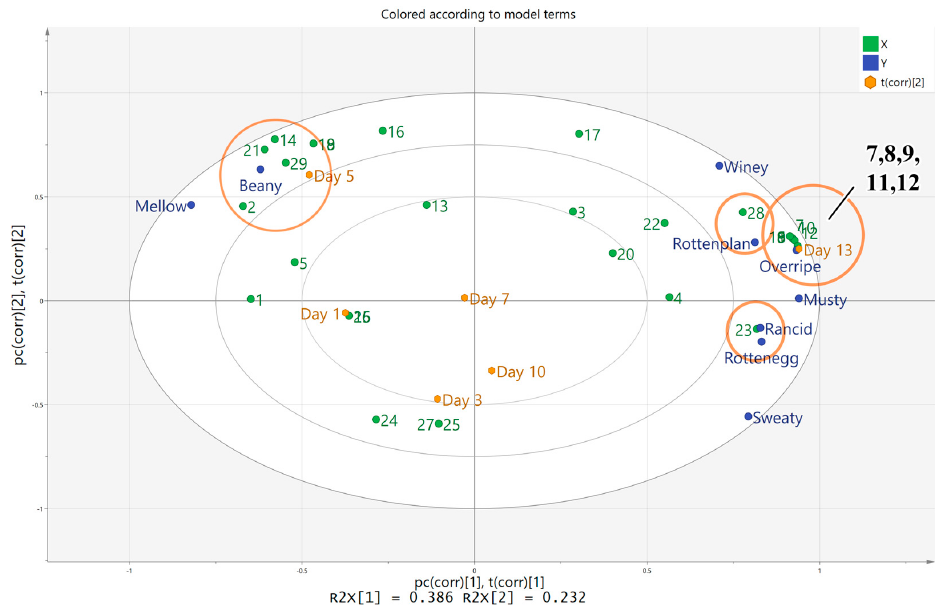
Figure 4. Partial least squares correlation plot from the analysis of the stinky tofu samples. The was derived from 29 volatile compounds with OAV greater than 1 as the X–matrix and the result of model was derived from 29 volatile compounds with OAV greater than 1 as the X − matrix and the sensory analysis as the Y–matrix. Codes 1–29 refer to the volatile compounds listed in Table result of sensory analysis as the Y − matrix. Codes 1–29 refer to the volatile compounds listed in Table 3.